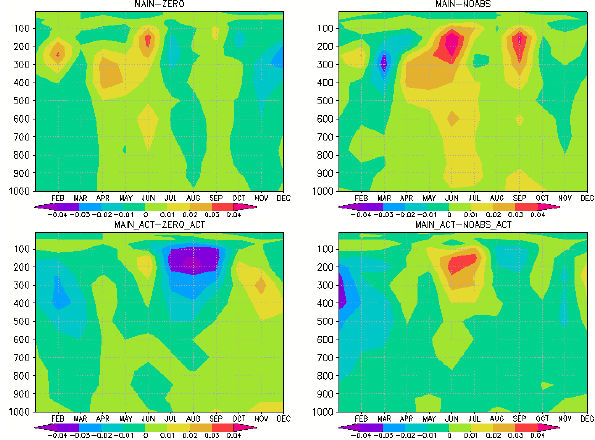
Figure 11. Cloud cover anomalies averaged over the longitude– latitude box 65–90 ◦ E, 5–35 ◦ N at different pressure levels in the different simulations, 7-year monthly means.